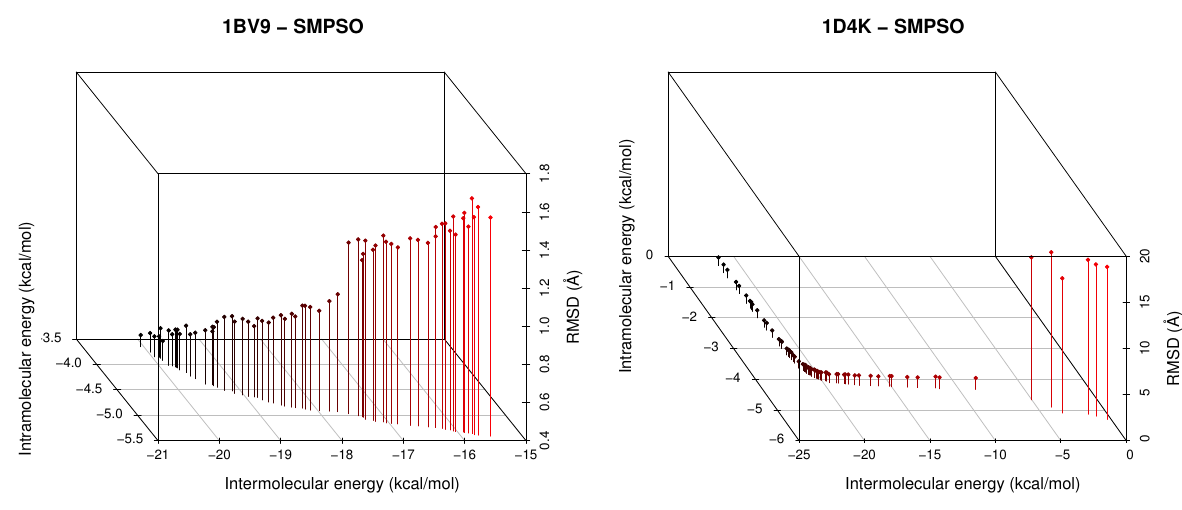
Figure 5. Non-dominated solution fronts of SMPSO for instances 1BV9 and 1D4K. The vertical bars represent the RMSD values for each solution. The solutions with better RMSD values are darker, that is the lower the RMSD, the better the docking solution